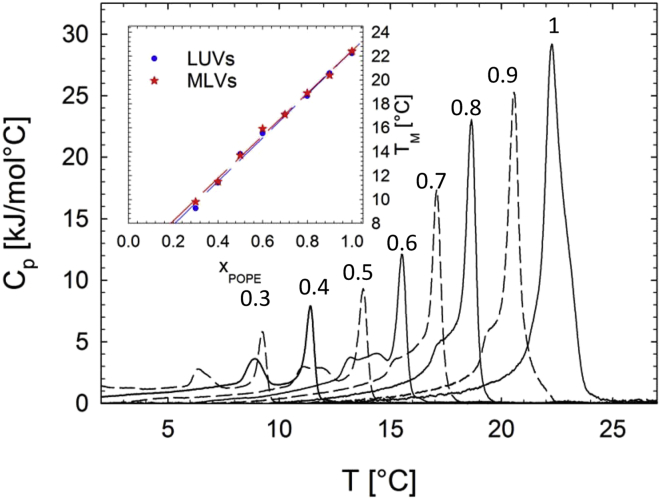
DSC cooling thermograms of POPE/POPC∗ mixtures. Numbers adjacent to the heat-capacity (cP) maxima indicate the given χPOPE. The inset shows the concentration dependence of the TM values of LUVs and MLVs, which served as controls (Fig. S2). To see this figure in color, go online.